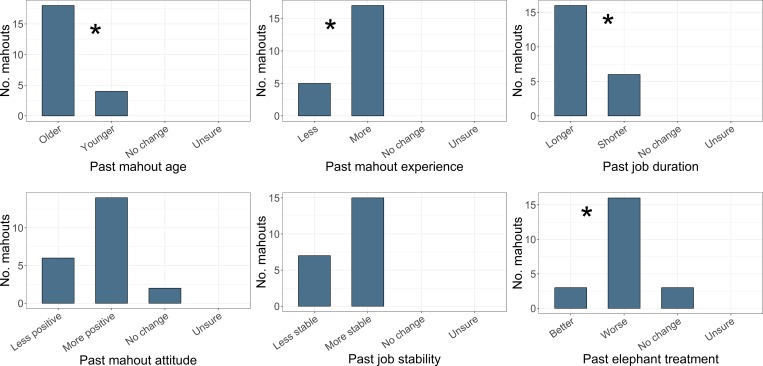
Expert’s observations of changes to elephant handling since they started working.The * symbol denotes statistical significance.